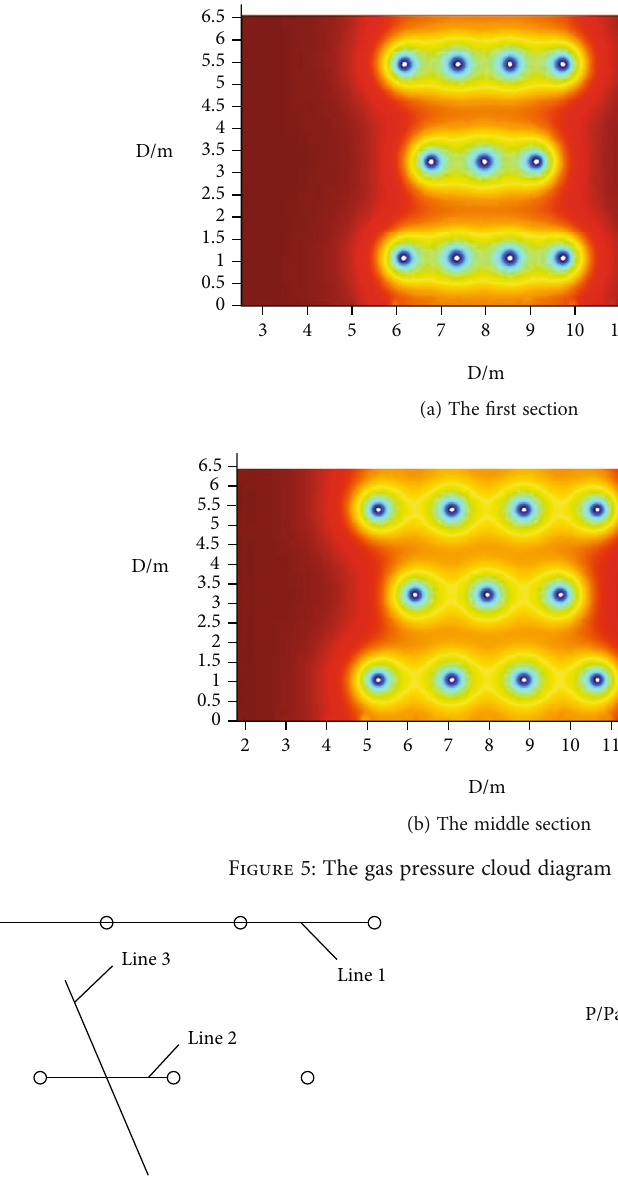
Figure 7: The value line graph. Table 3: E ff ective borehole spacing values in di ff erent